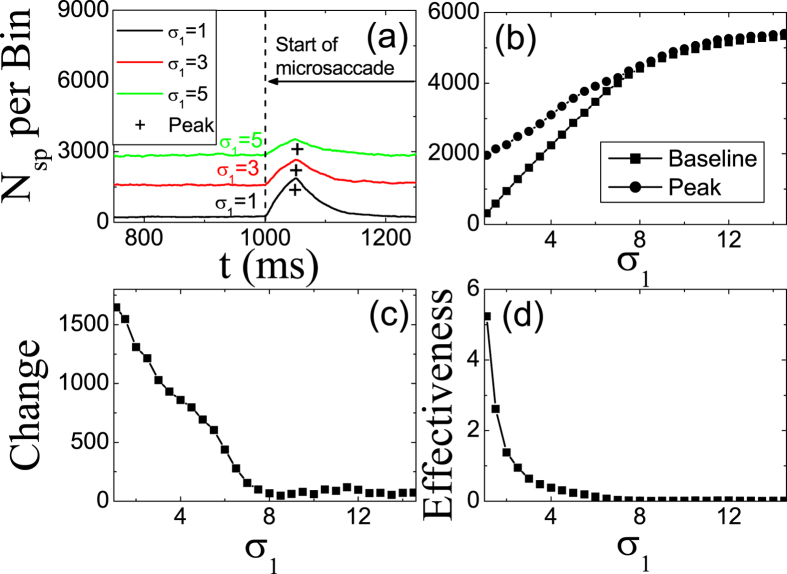
The same as in Fig. 2, but for different σ1.The parameters are g = 0.2, A = 100, ΔM = 2.0 and σ2 = 1.5.